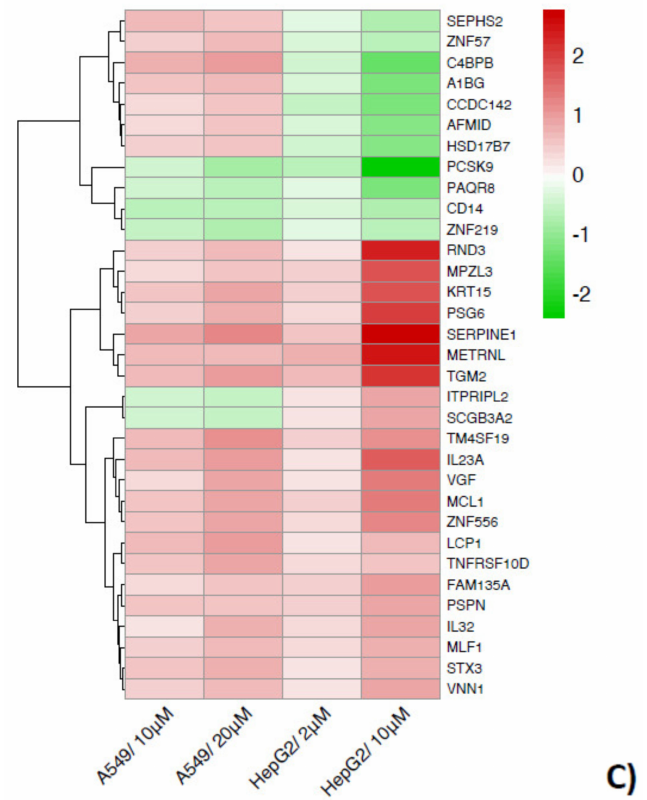
Figure 4. Heatmaps of two by two comparison of regulated genes in human lung cancer cells (A549), human neuronal cells (SH-SY5Y), and human hepatoma cells (HepG2). The cell model used for comparison and Cd concentrations are indicated. ( A ) comparison between A549 and SH- SY5Y cells, ( B ) between SH-SY5Y and HepG2 cells, and in ( C ) A549 and HepG2 are compared. Upregulated (red) and downregulated (green) genes are indicated in the heatmap along with the name of regulated